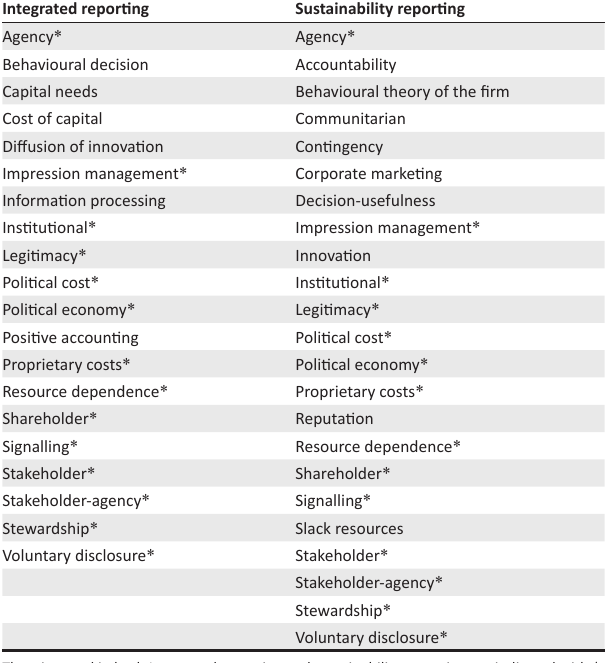
TABLE 1: Theories identified to explain integrated reporting and sustainability reporting between 2010 and 2019. Integrated